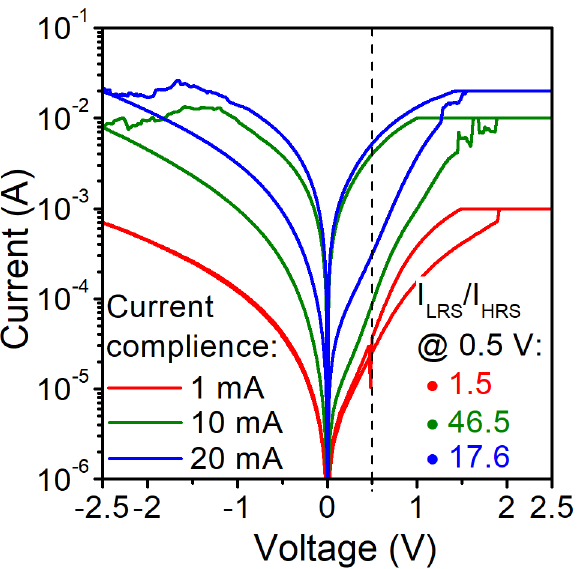
Figure 5. Measured current-voltage characteristics of Al/SiO2/n ++ Si RRAM structure S2 with the gate diameter of 74 μm and various compliance set currents.